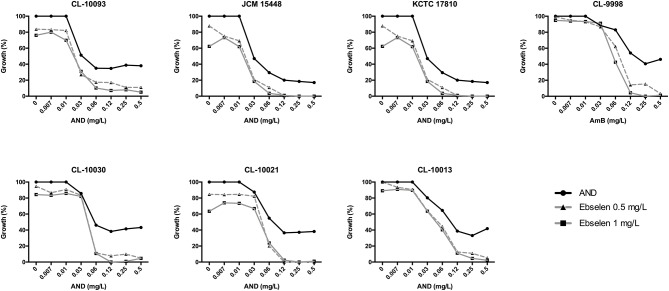
Representative graphs of the synergistic effect of AND (ranging concentration: 0.007–0.5 mg/L) in combination with 0.5 and 1 mg/L of ebselen against C. auris strains by checkerboard assay.